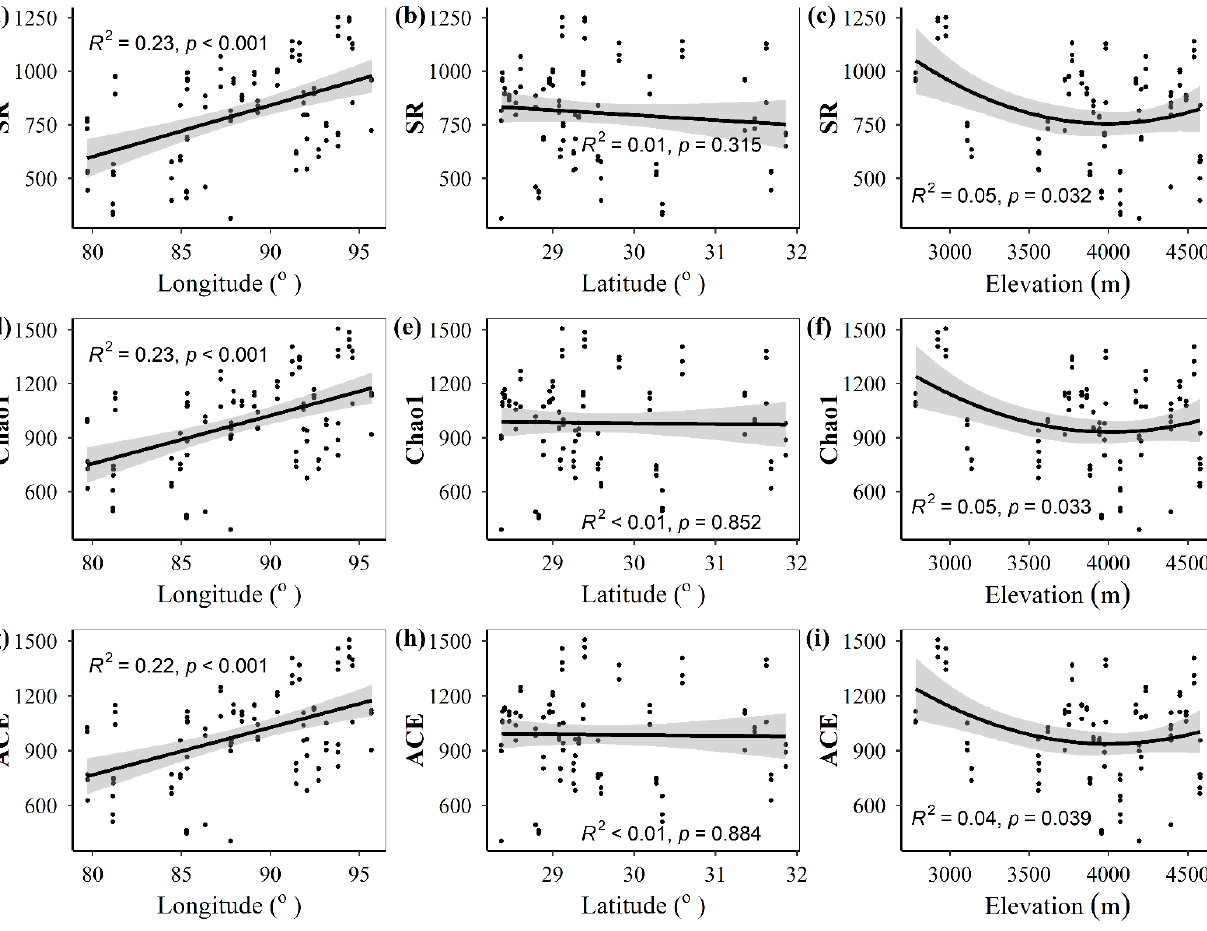
Figure A11. Cont